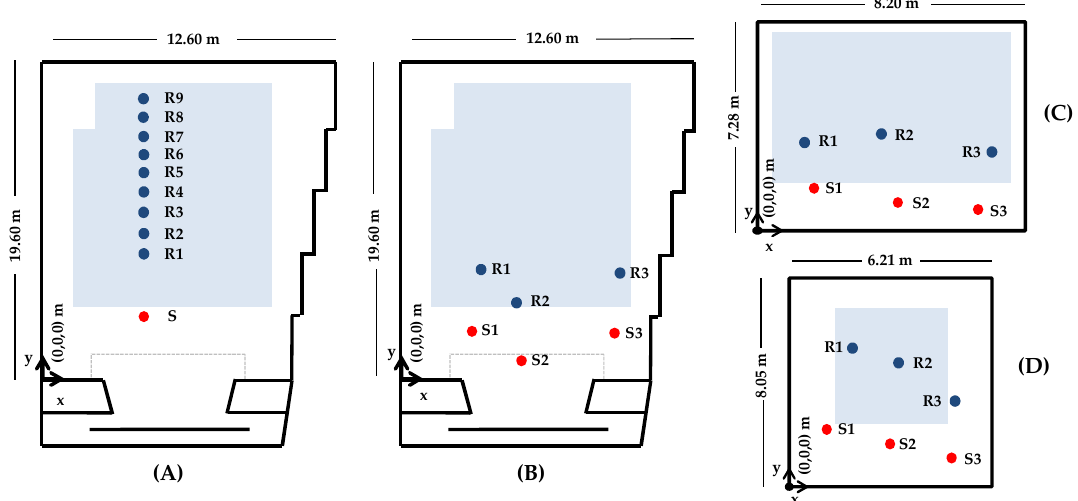
Figure 2. (A) presents source (S: red circles) and receiver (R: blue circles) positions for measurements at different source–receiver distances. (B–D) present source and receiver positions for measurements in the large, medium and small space respectively (exact source and receiver positions are provided in Tables A1 and A2 in Appendix A).